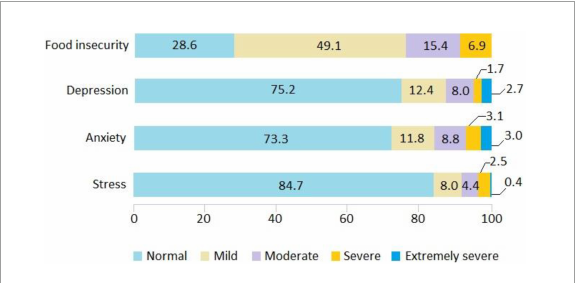
FIGURE1 Prevalence of food insecurity and mental health outcomes in Peruvian households during the COVID-19 pandemic.